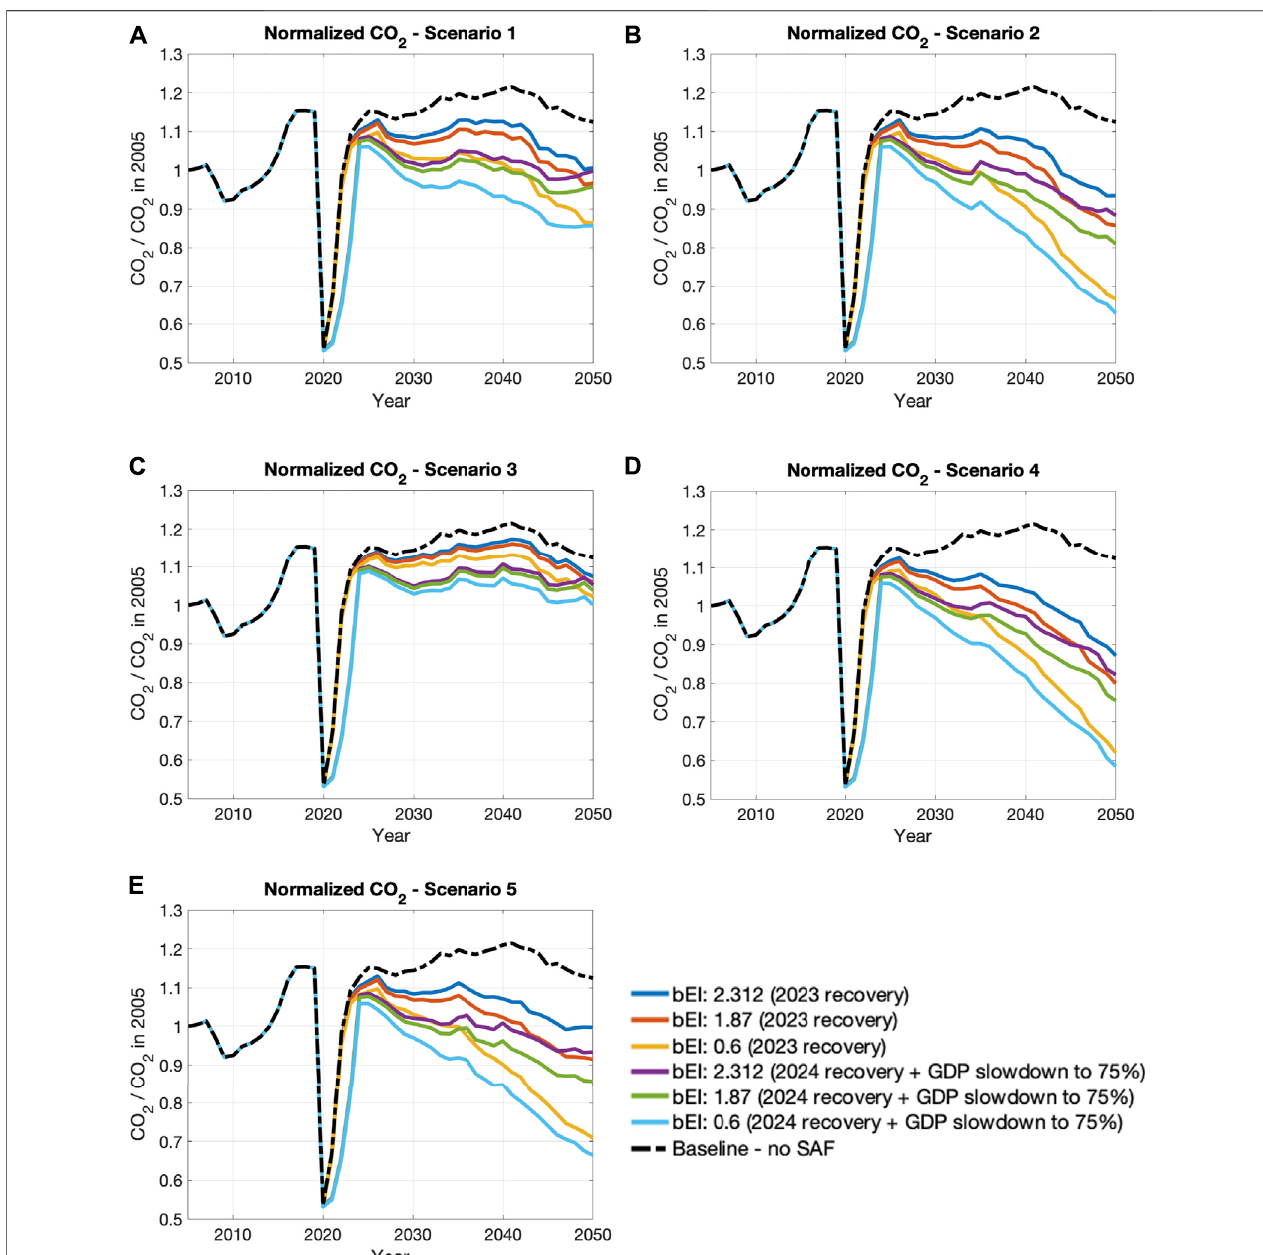
FIGURE 11 | Normalized fl eet-level CO 2 emissions for different SAF scenarios considering multiple biofuel emission intensities and future demand growth projections – (A) Scenario 1: reference biofuel price, reference penetration level, (B) Scenario 2: reference biofuel price, high penetration level, (C) Scenario 3: reference biofuelprice,lowpenetrationlevel, (D) Scenario4:constantbiofuelprice,highpenetrationlevel, (E) Scenario5:specialbiofuelprice,highpenetrationlevel; ‘ bEI ’ refersto ‘ biofuel emission intensity ’ (in lb CO2-equivalent per lb consumed fuel.